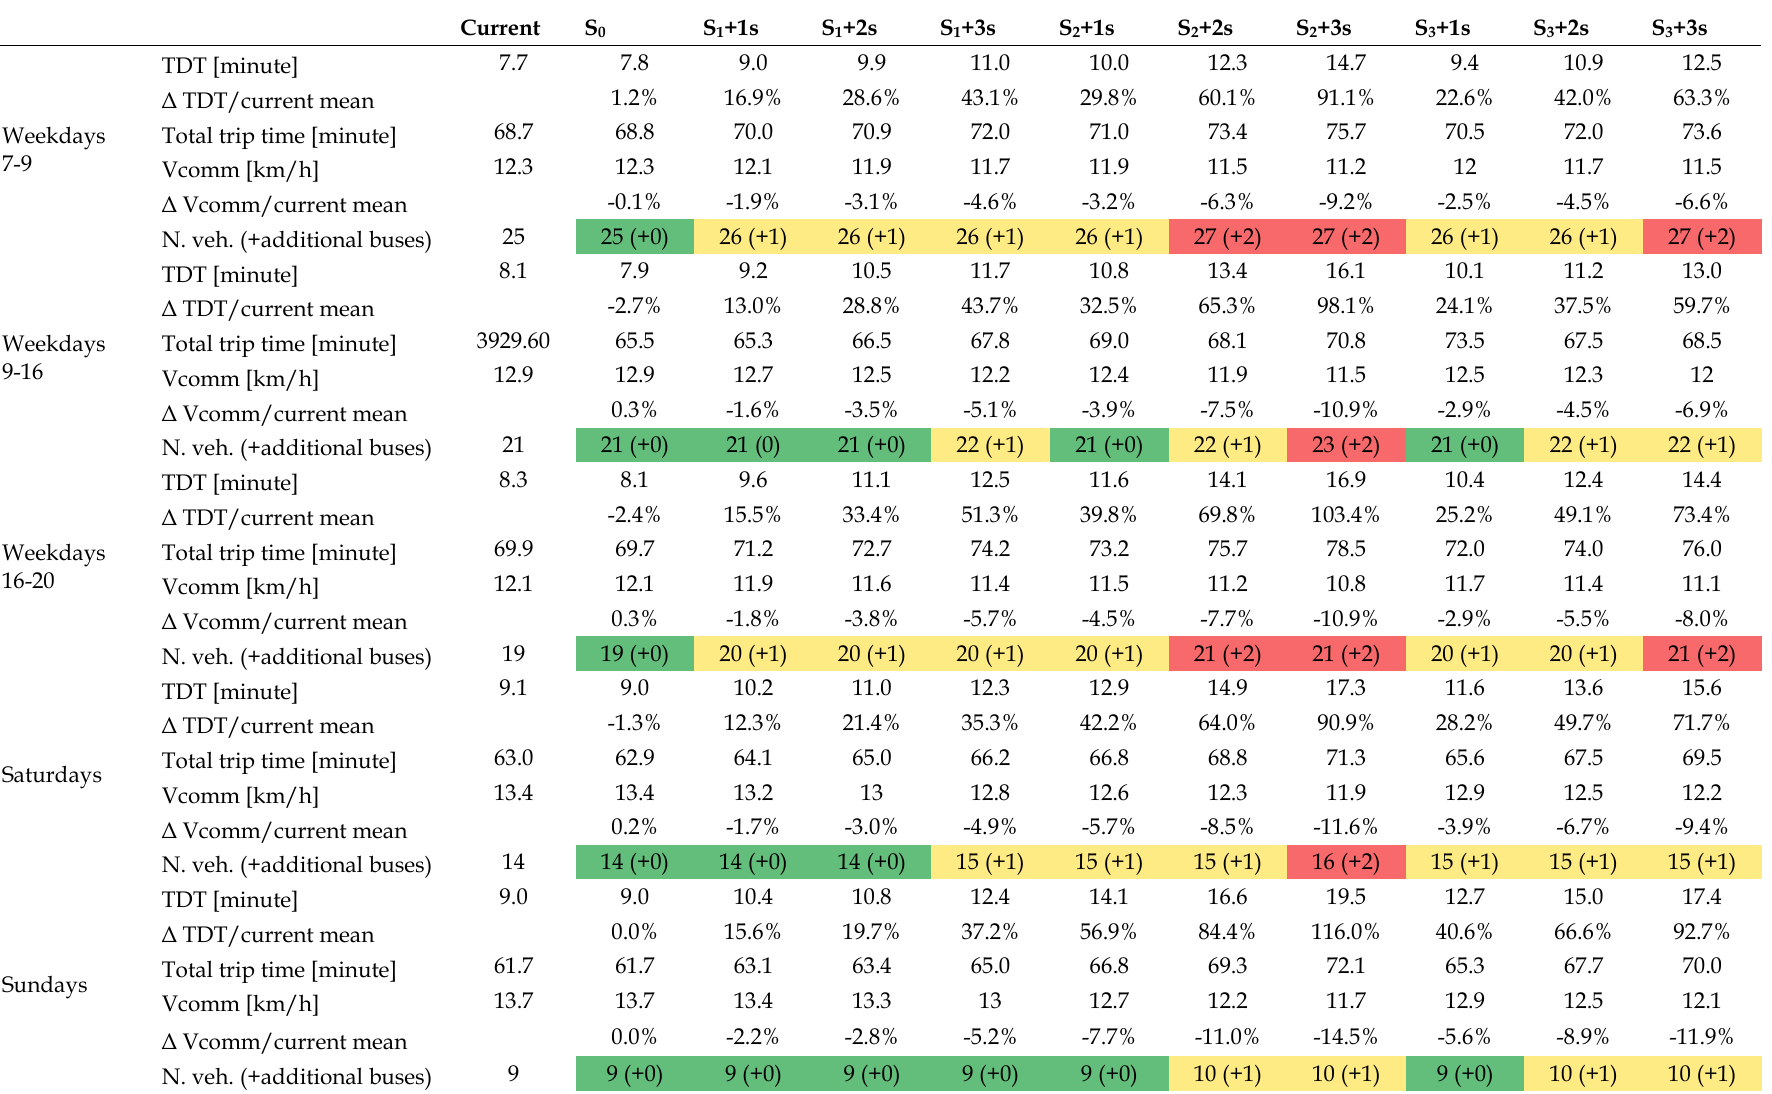
Table 5. Results of simulations of the different